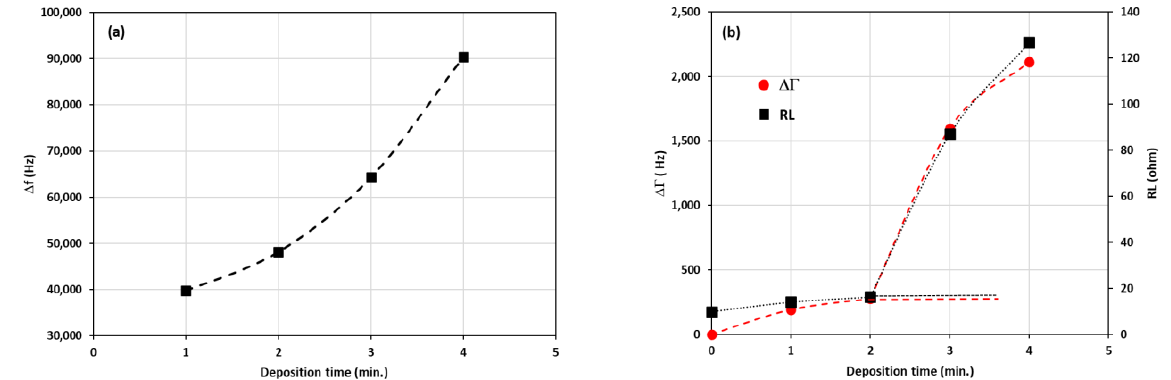
Figure 8. ( a ) The frequency shifts ( ∆ f ) due to the variation of deposition time. The frequency of the untreated QCM was 11.18 MHz. ( b ) The half-bandwidth changes ( ∆Γ ) and the series load resistance (R L ) for the layers deposited at the various time. The half-bandwidth of the untreated QCM was 65.9 Hz.